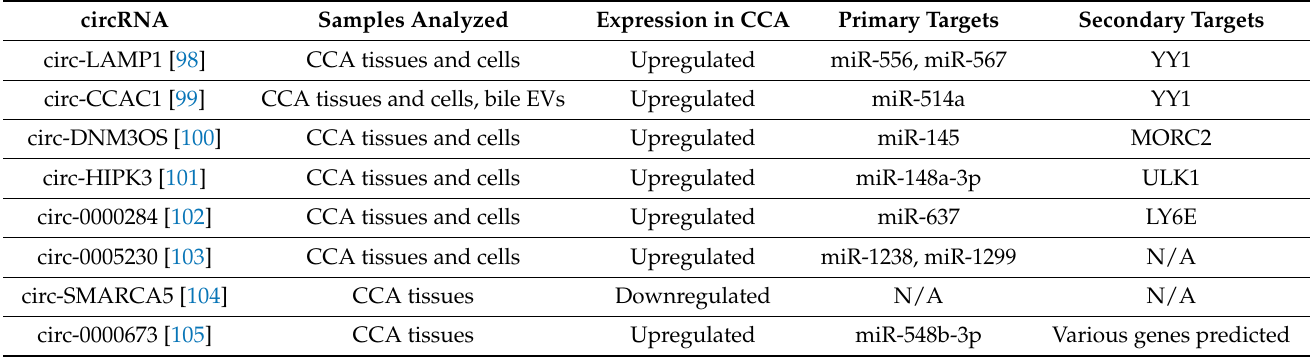
Table 5. Selected circRNAs identified in recent CCA